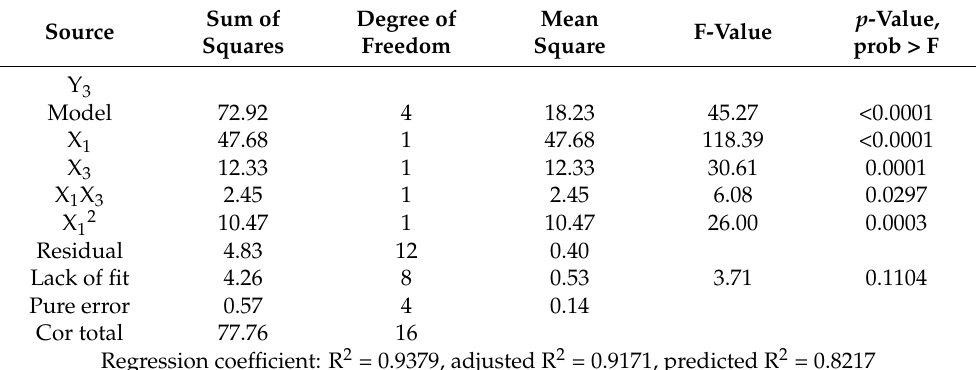
Table 6. ANOVA results of the fitted model for predicting Y 3